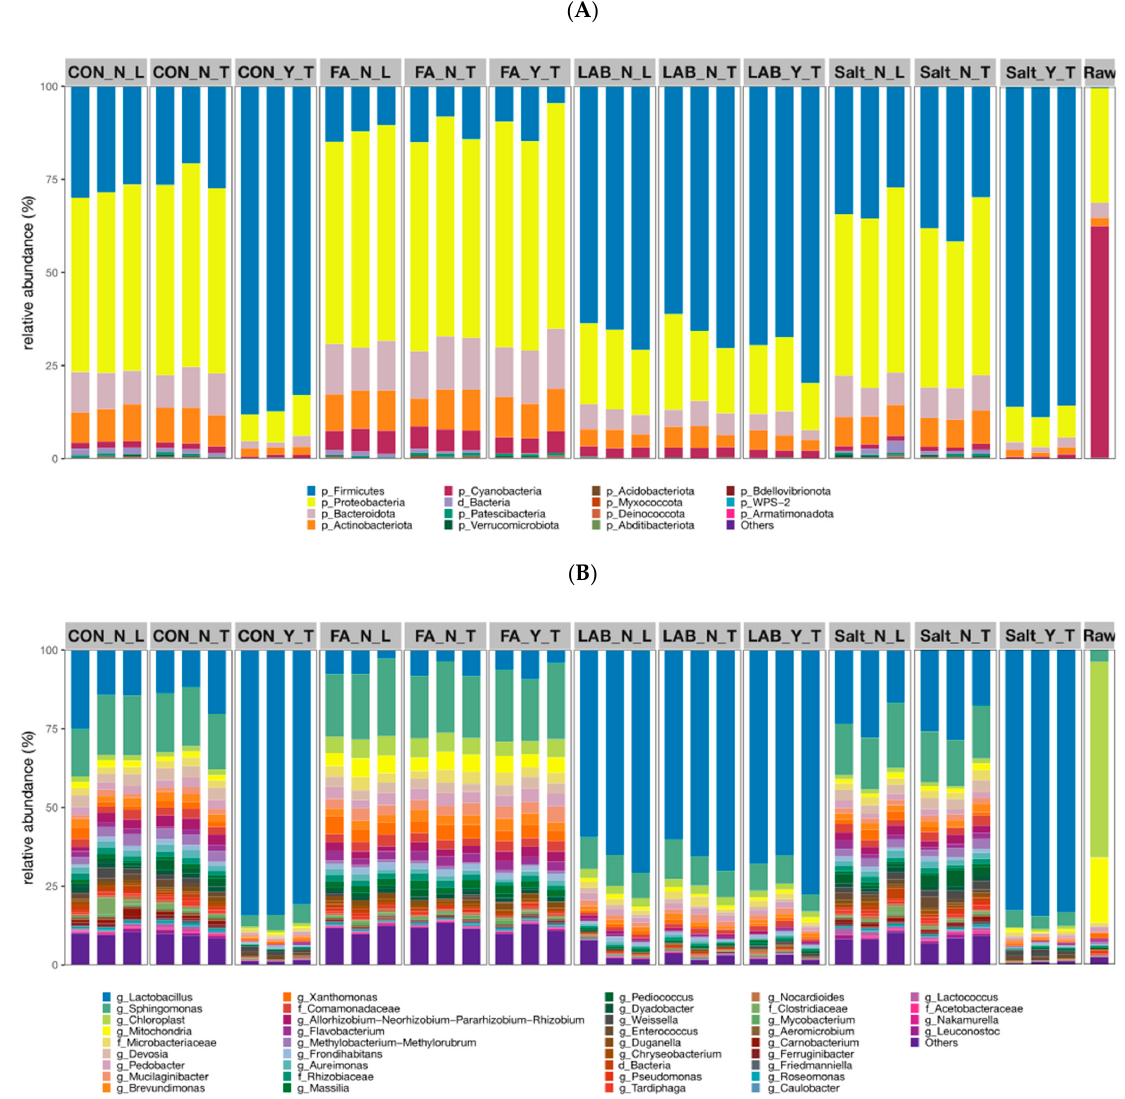
Figure 2. Relative abundance of bacterial communities of grass silage treated with different addi- tives under two compaction and soil contamination levels. ( A ) : Phylum taxonomic level, ( B ) : Genus taxonomic level, CON: Control, FA: Formic acid-based additive, LAB: Lactic acid bacteria additive, Salt: Salt based additive, N: non-contaminated, Y: contaminated, L: loose compaction, T: tight com- paction, Raw: raw material before ensiling.